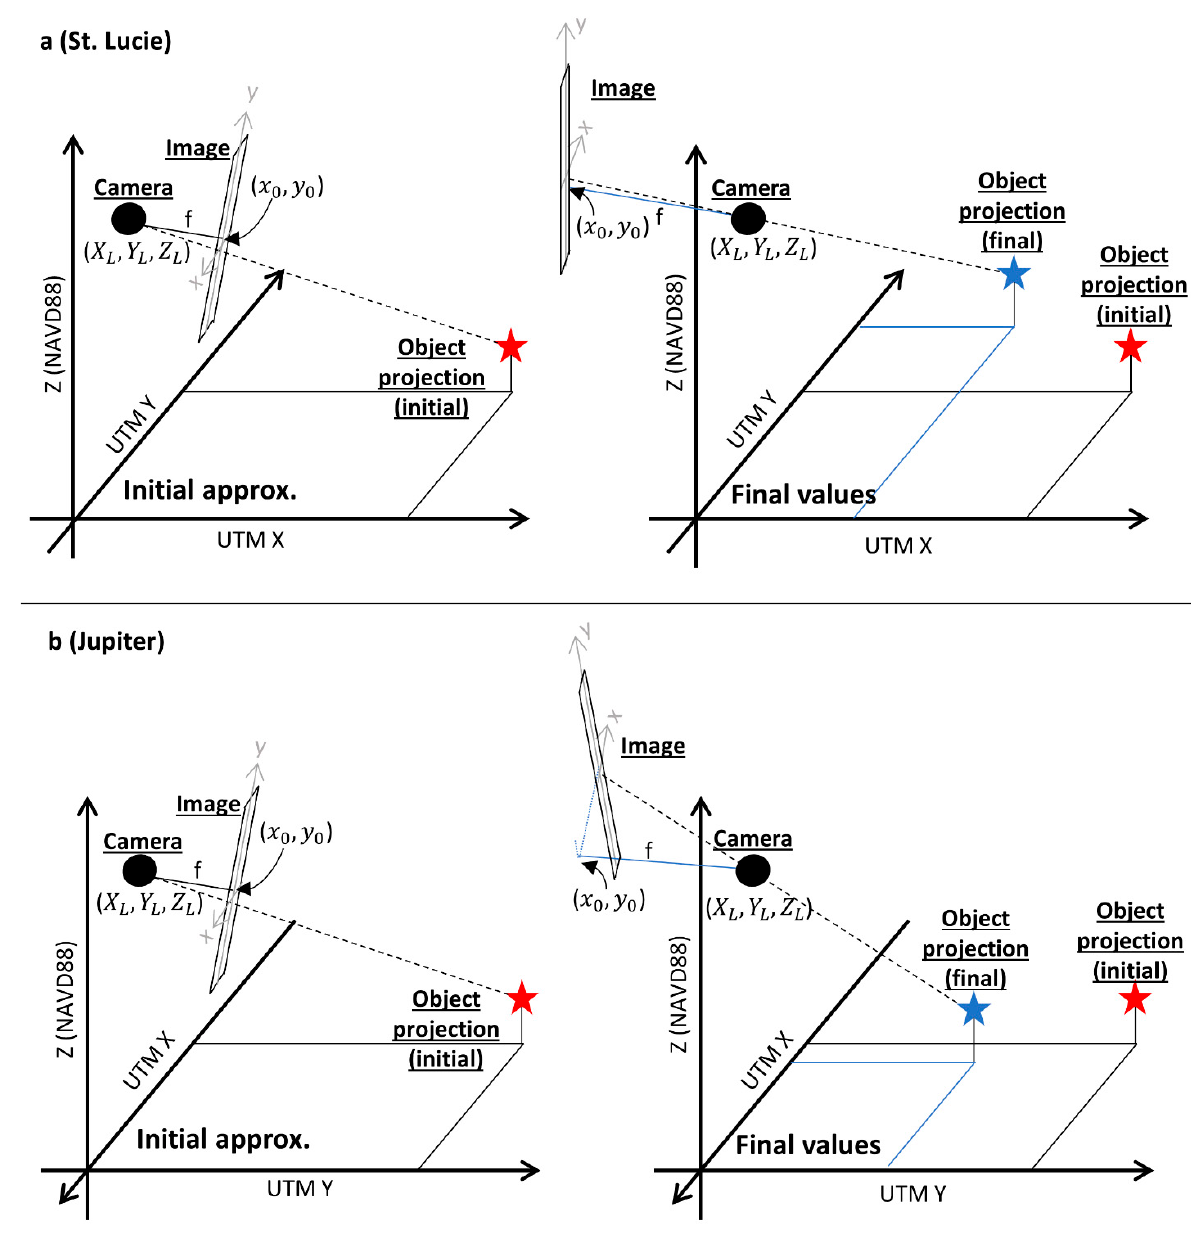
Figure 4. Approximate collinear geometry of the initial camera parameter approximations ( left ) and final adjusted parameter values ( right ) for the St. Lucie ( a ) and Jupiter ( b ) cameras. Blue symbols in the right panels represent those that are >25% different from those in the left.